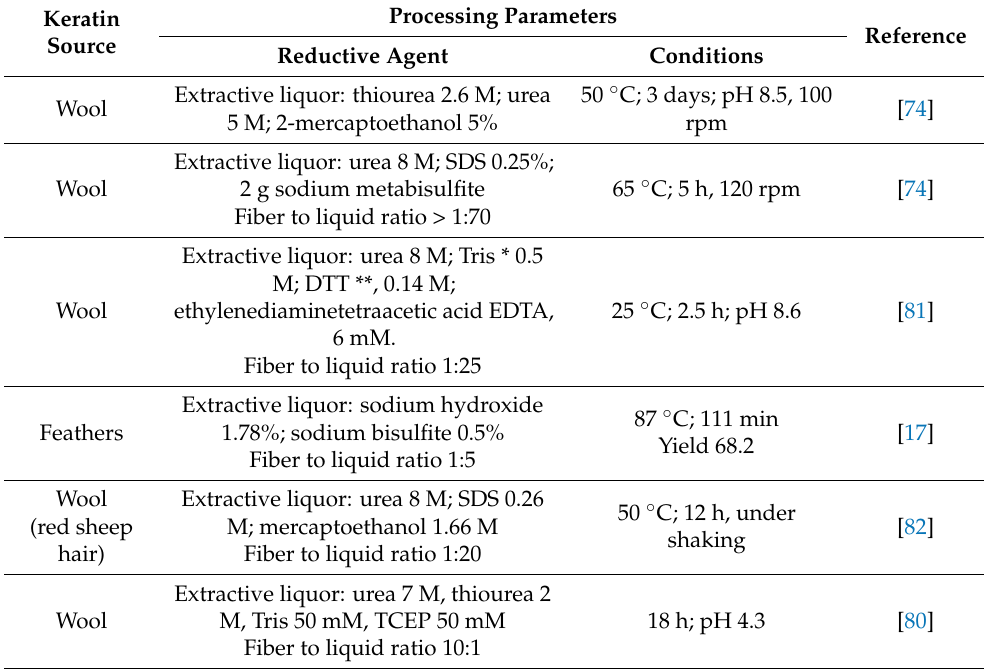
Table 3. Optimized reductive extraction conditions and processing parameters used for the keratin extraction.